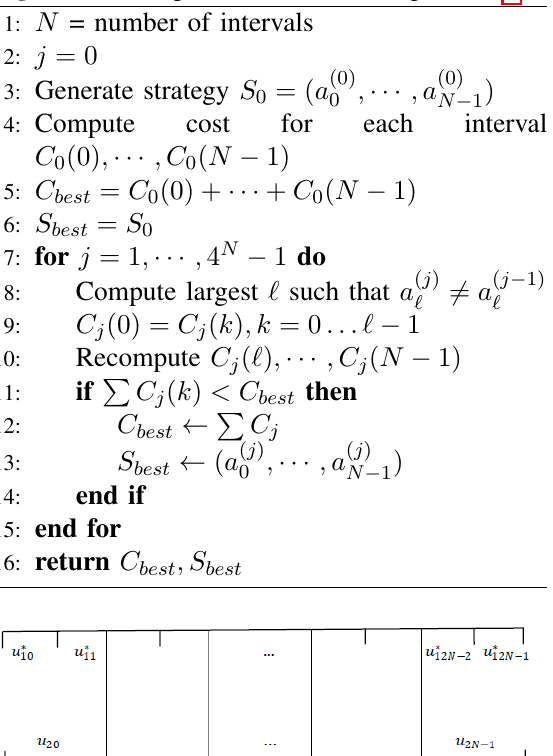
Algorithm 2 Improved version of Algorithm 1.